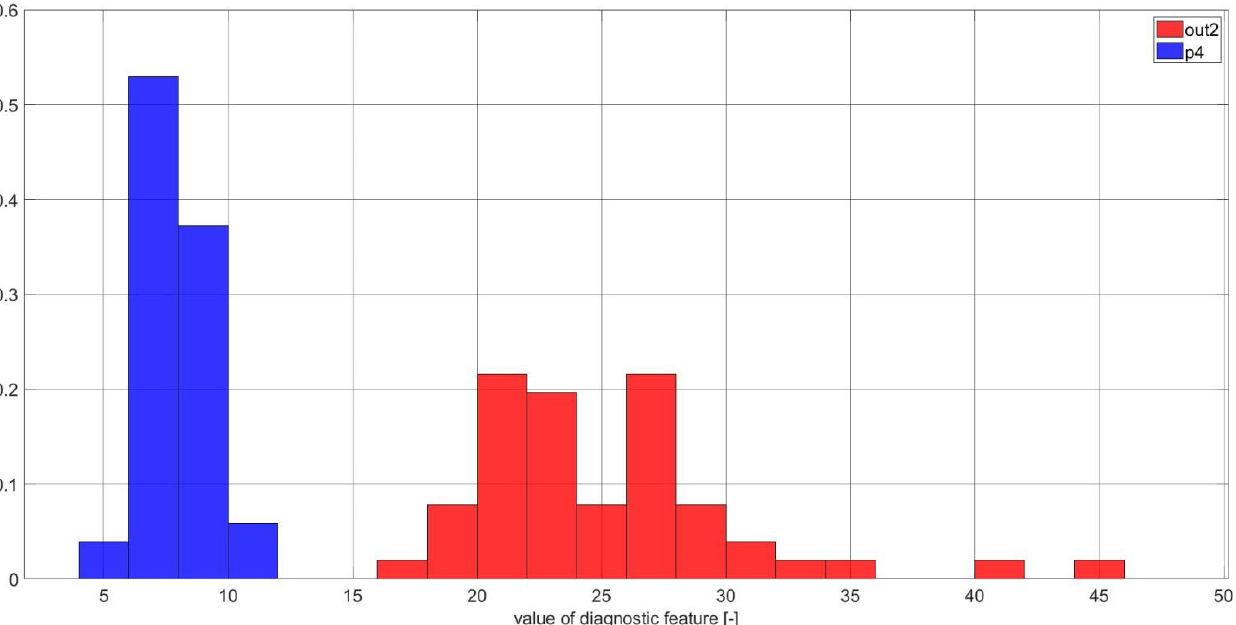
Figure 11. Histograms of diagnostic features based on the CCSM3 (correlation number is 4, Table A2) bearings out2 and p4.